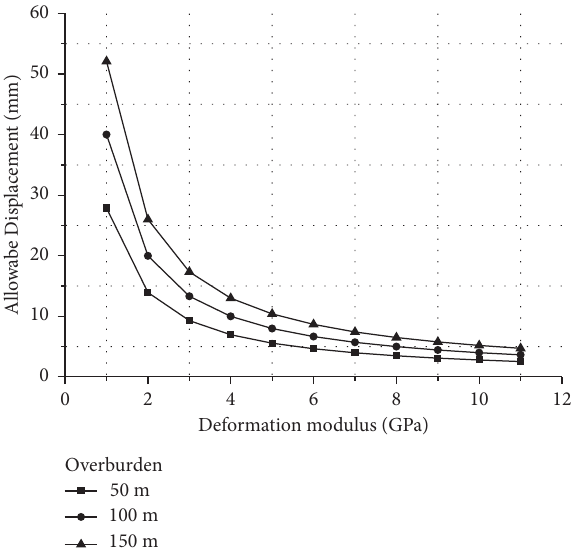
Figure 6: The curve of allowable displacement vs. deformation modulus.